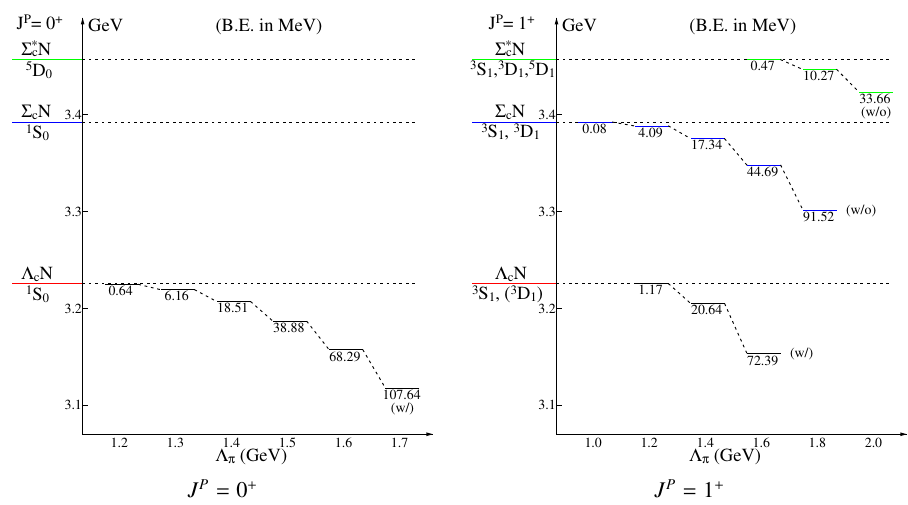
Fig. 2. The sensitivity of the binding energy (B.E.) to the cuto ff Λ π in the OPEP model for the J P = 0 + and J P = 1 + cases. The cases without (w / o) and with (w / ) channel coupling are both shown. ( 3 D 1 ) means there is no S − D mixing when one considers only the Λ c N channel.